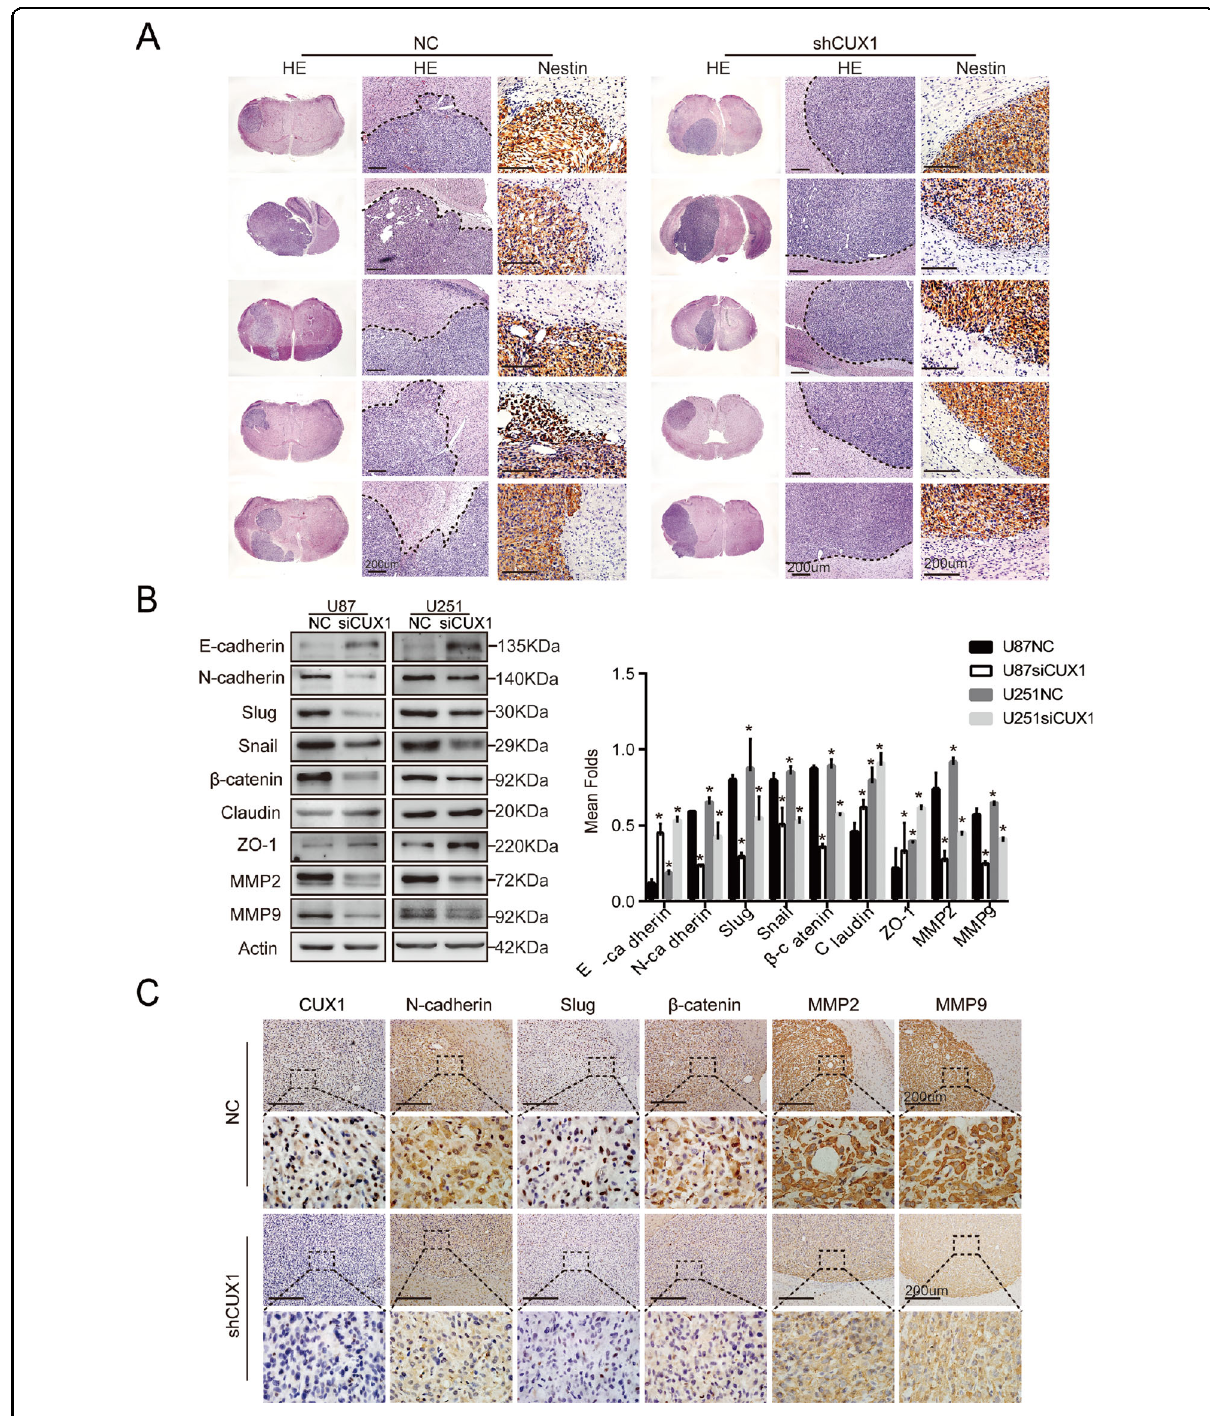
Fig. 3 CUX1 knockdown inhibited cell migration and invasion by regulating EMT progression and MMPs expression in vitro and in vivo. a Representative images of intracranial tumor xenograft with U87 cell lines in nude mice. HE and IHC of human Nestin staining revealed that the CUX1 knockdown inhibited the aggressive phenotype in vivo (NC, n = 5; ShCUX1, n = 5). b WB assay revealed that the CUX1 knockdown in U87 and U251 cells regulated the expression of EMT-associated proteins and MMPs in vitro, including reduced the expression of N-Cadherin, Slug, Snail, β -Catenin, MMP2, and MMP9, and enhanced the expression of E-Cadherin, Claudin, and ZO-1(* P < 0.05). c IHC staining showed that CUX1 knockdown inhibited the EMT-related protein expression including N-Cadherin, Slug, β -catenin, MMP2, and MMP9 in